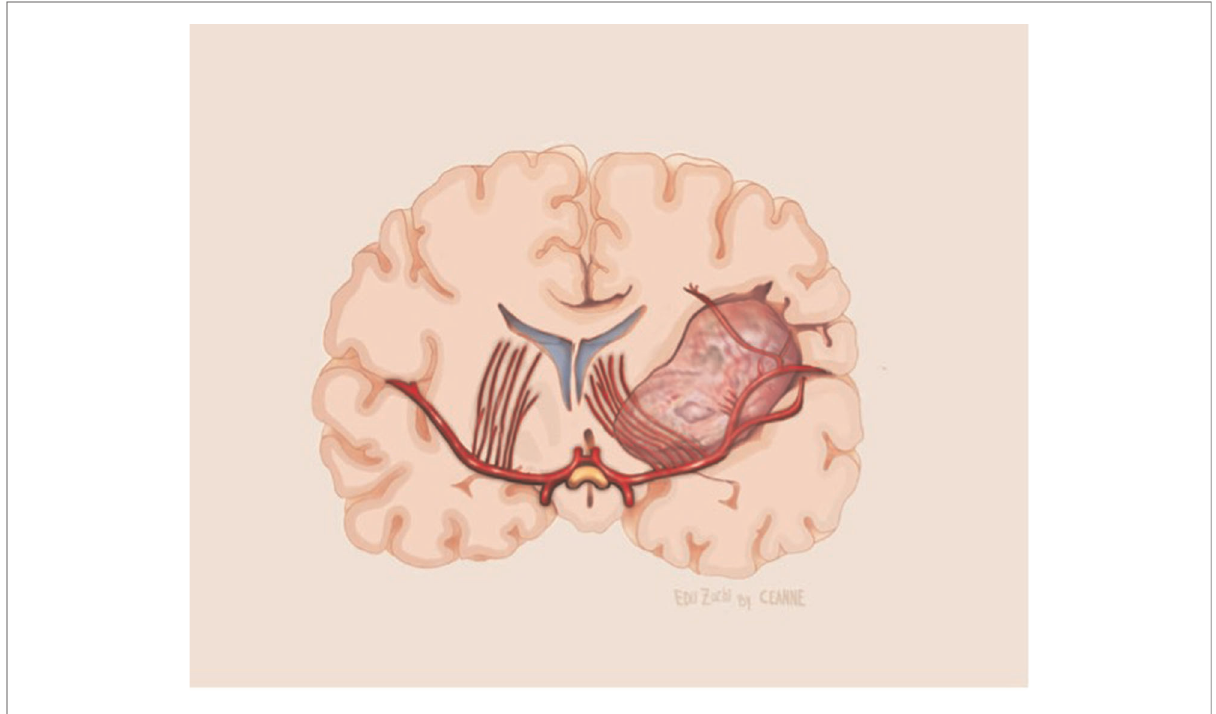
FIGURE 10 Illustrative drawing of coronal section showing the lenticulostriate arteries involvement by the medial portion of the insular glioma.